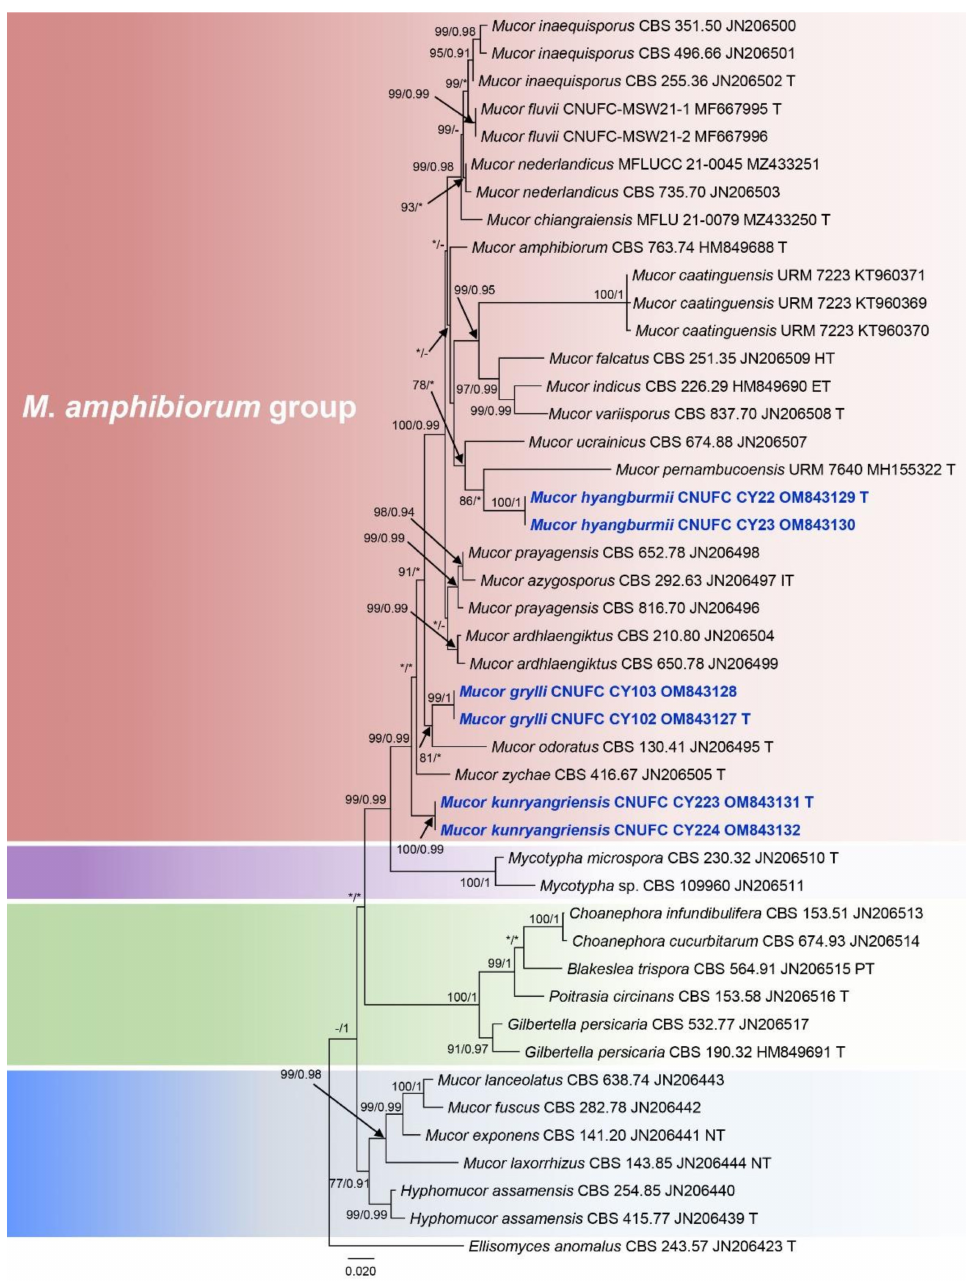
Figure 2. Phylogenetic tree constructed by maximum likelihood analysis of the LSU. The numbers above branches represent maximum likelihood bootstrap percentages (left) and Bayesian posterior probabilities (right). Bootstrap values ≥ 70% and Bayesian posterior probabilities ≥ 0.90 are shown. Bootstrap values lower than 0.90 and 70% are marked with “*”, and absent bootstrap values are marked with “-”. The bar indicates the number of substitutions per position. Ellisomyces anomalus CBS 243.57 was used as outgroup. Type, ex-neotype, ex-holotype, and ex-epitype strains are marked with T, NT, HT, and ET, respectively. Newly generated sequences are in blue bold